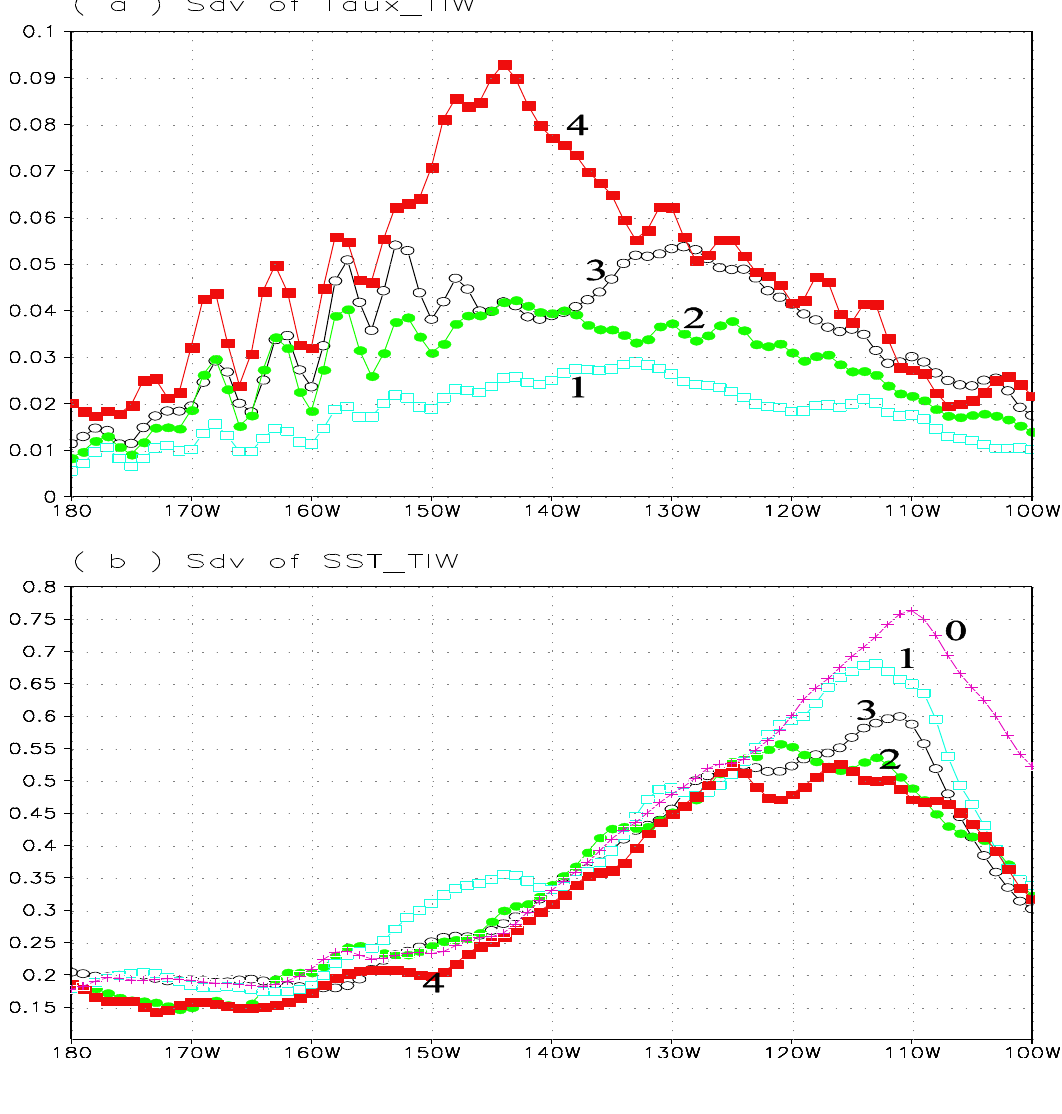
Figure 12. Zonal distributions along 2  N for the sdv of ( a ) the zonal τ fields, calculated using daily data in year 13. The results are given for the feedback runs with α = 3.0 (the line with open circles), α = 1.0 (the line with open squares), α TIW TIW line with full circles), and α = 4.0 (the line with full squares), respectively. Also given in TIW (b) is the sdv of SST calculated from the no-feedback run (the line with plus symbols). TIW The unit is dyn·cm −2 in (a) and °C in